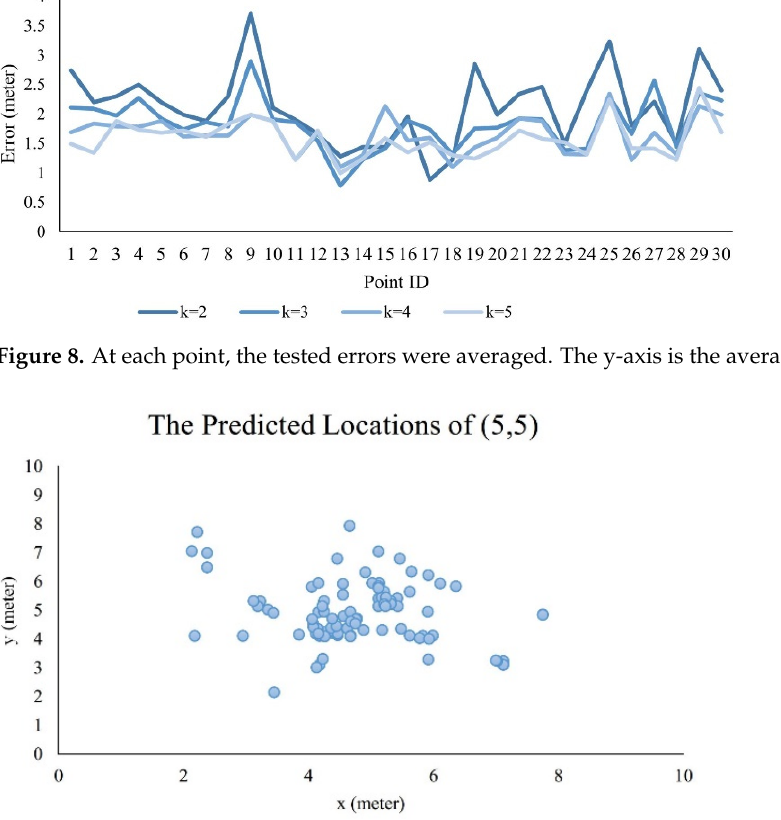
Figure 10. Predicted locations obtained during walking.